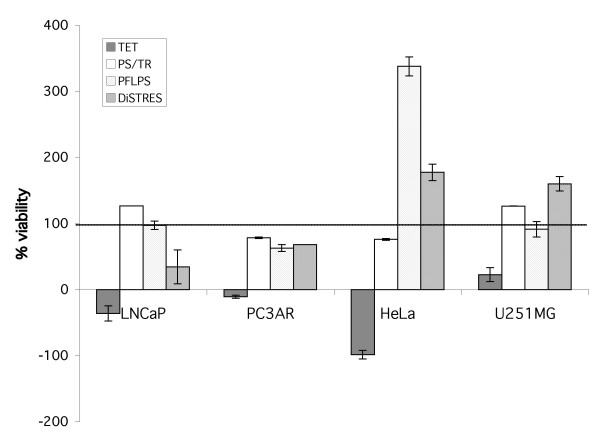
Ad/FasL-GFPDiSTRES demonstrates preferential cytotoxicity in prostate cells. LNCaP, PC3AR, U251MG, and HeLa cells were seeded at 1.25 × 104 cells/well in a 96-well plate and infected with Ad/FasL-GFPTET, Ad/FasL-GFPPS/TR, Ad/FasL-GFPPFLPS, Ad/FasL-GFPDiSTRES, or 1× HBS (mock) in the presence of 30 nM DHT. LNCaP, PC3AR, U251MG, and HeLa were infected at MOI 10, 5, 5, and 2.5, respectively. Three days post-infection, cells were fixed with methanol and then assayed for cytotoxicity using crystal violet assay. Since each cell type showed varying sensitivities to adenovirus-delivered FasL-GFP, we infected each cell type at MOI values determined during pilot studies to induce maximal cytotoxicity in response to Ad/FasL-GFPTET control. Percent viability was calculated by dividing the mean absorbance of each sample by the mean absorbance of 1× HBS mock infection for each cell line and then multiplying by 100%. MOI values were based on pfu/ml. Horizontal line delineates 100% viability.